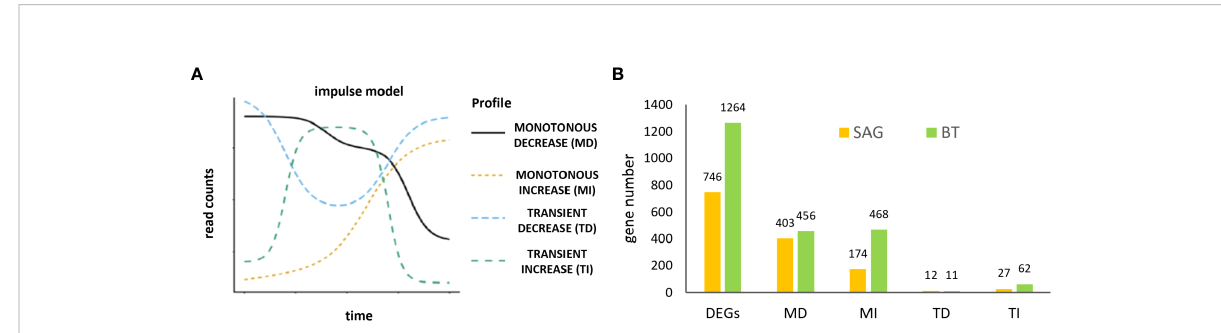
FIGURE 3 Expression pro fi ling of time course transcriptome data using ImpulseDE2 (Fischer et al., 2018) to identify clusters of genes that are continuously up- or down-regulated MONOTONOUS INCREASE (MI) and DECREASE (MD) genes and transiently up- or down-regulated, TRANSIENT INCREASE (TI) and DECREASE (TD) (A) ; numbers of differentially expressed genes (DEGs) in the MI, MD, TI and TD clusters for SAG peach and BT nectarine (B)